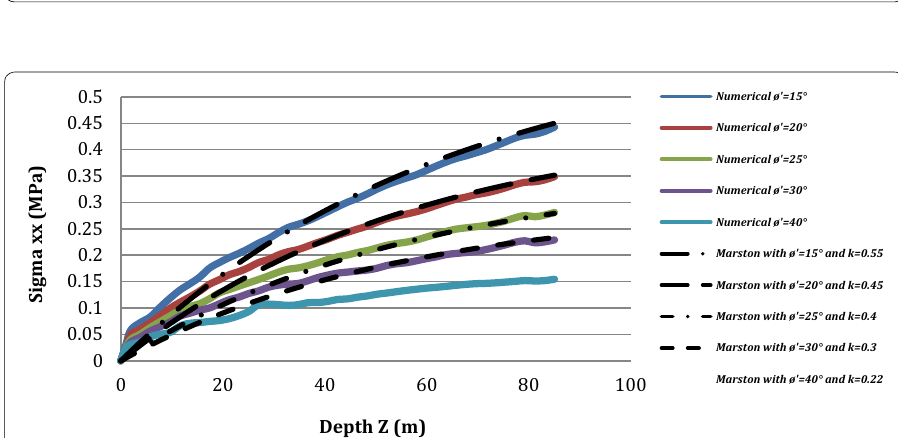
Fig. 9 Horizontal stress estimates for determining the best-fit K value at various friction angles φ ′ in a model measuring 6 45 m ×